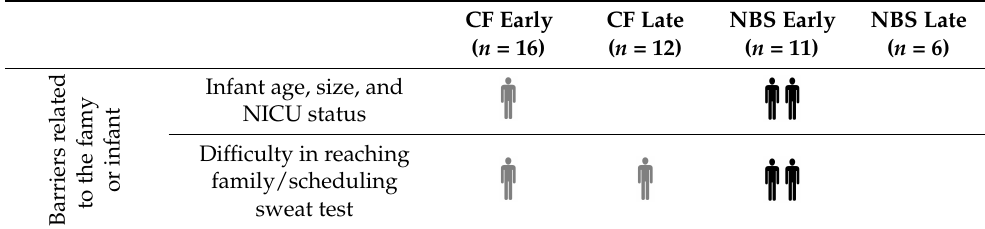
Table 4. Key barriers identified listed by analysis groups regarding the infant or family related to timely sweat testing; themes identified by at least 30% of the group are represented by one figure; themes identified by at least 60% of the group are represented by two